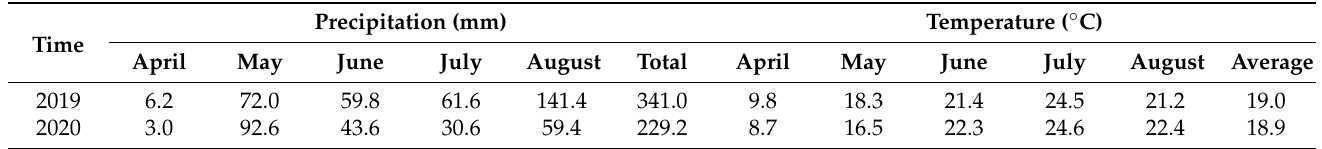
Table 1. Precipitation and temperature during the growing season from April to August in two experimental years.